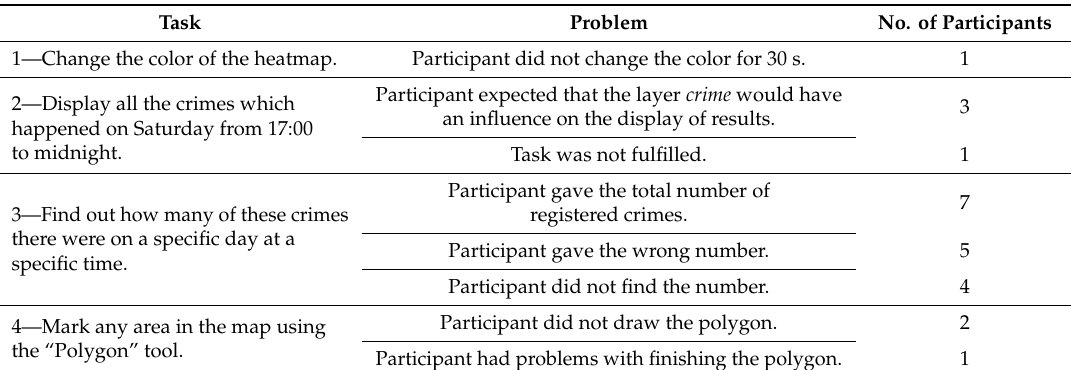
Table 2. Problems identified with the Chicago map.